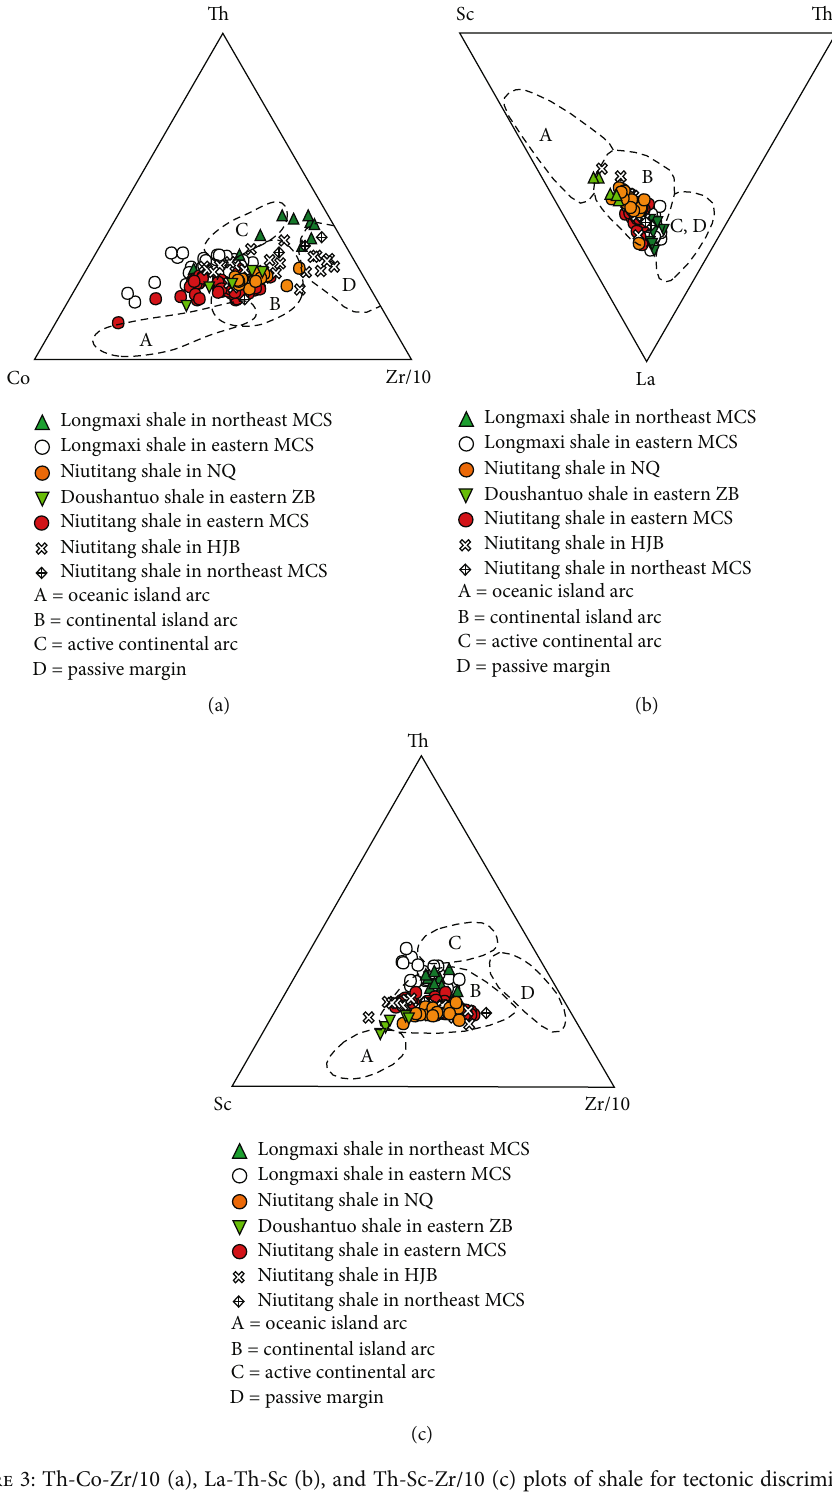
Figure 3: Th-Co-Zr/10 (a), La-Th-Sc (b), and Th-Sc-Zr/10 (c) plots of shale for tectonic